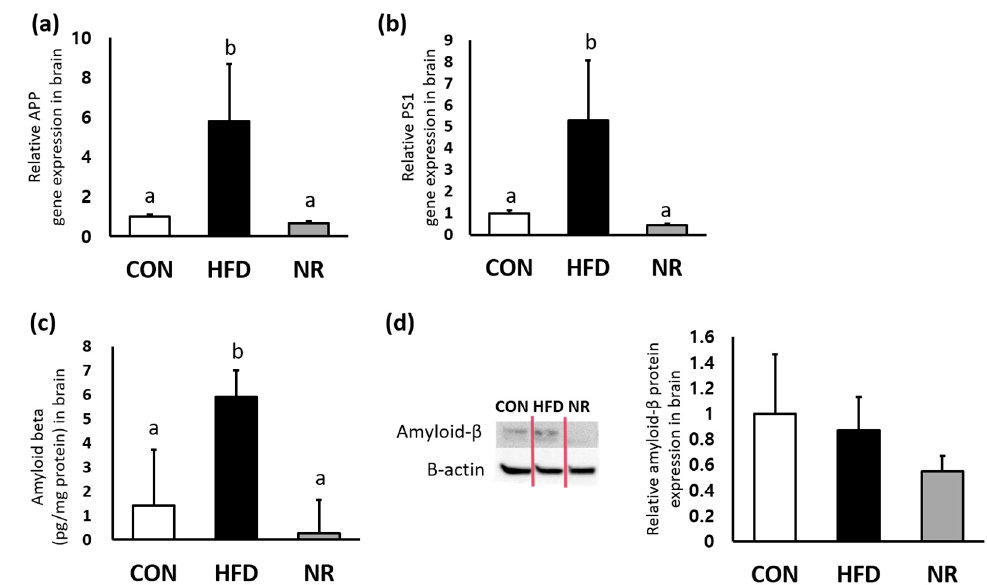
Figure 2. The effects of nicotinamide riboside (NR) on amyloid-beta precursor protein (APP), presenilin1 (PS1), and amyloid- β in the whole brain of mice. Relative gene expression of ( a ) APP and ( b ) PS1 . ( c ) Amyloid beta concentrations in brain were analyzed by ELISA. ( d ) Representative Western blot for amyloid beta and beta-actin, and their respective quantification in brain. Values represent the mean ± SEM ( n = 5 per group). Values with different letters in the same variable are significantly different ( p < 0.05). CON, control; HFD, high-fat diet.